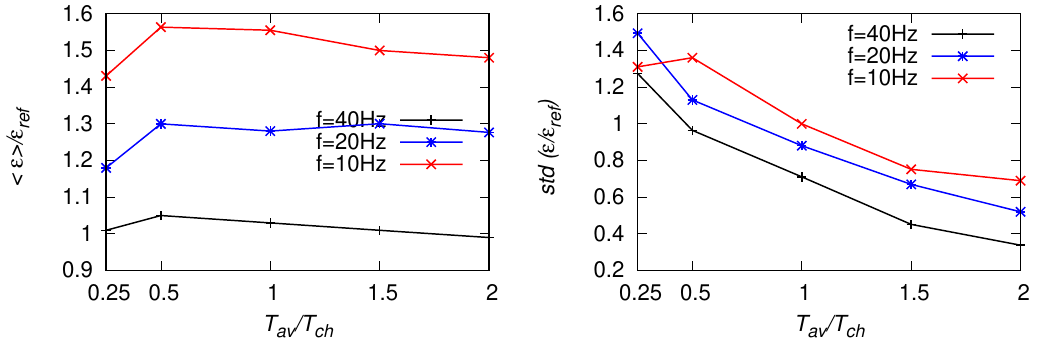
Figure 25. As in Figure 24 but for the fitting range f = [ 0.2 ÷ 5 ]